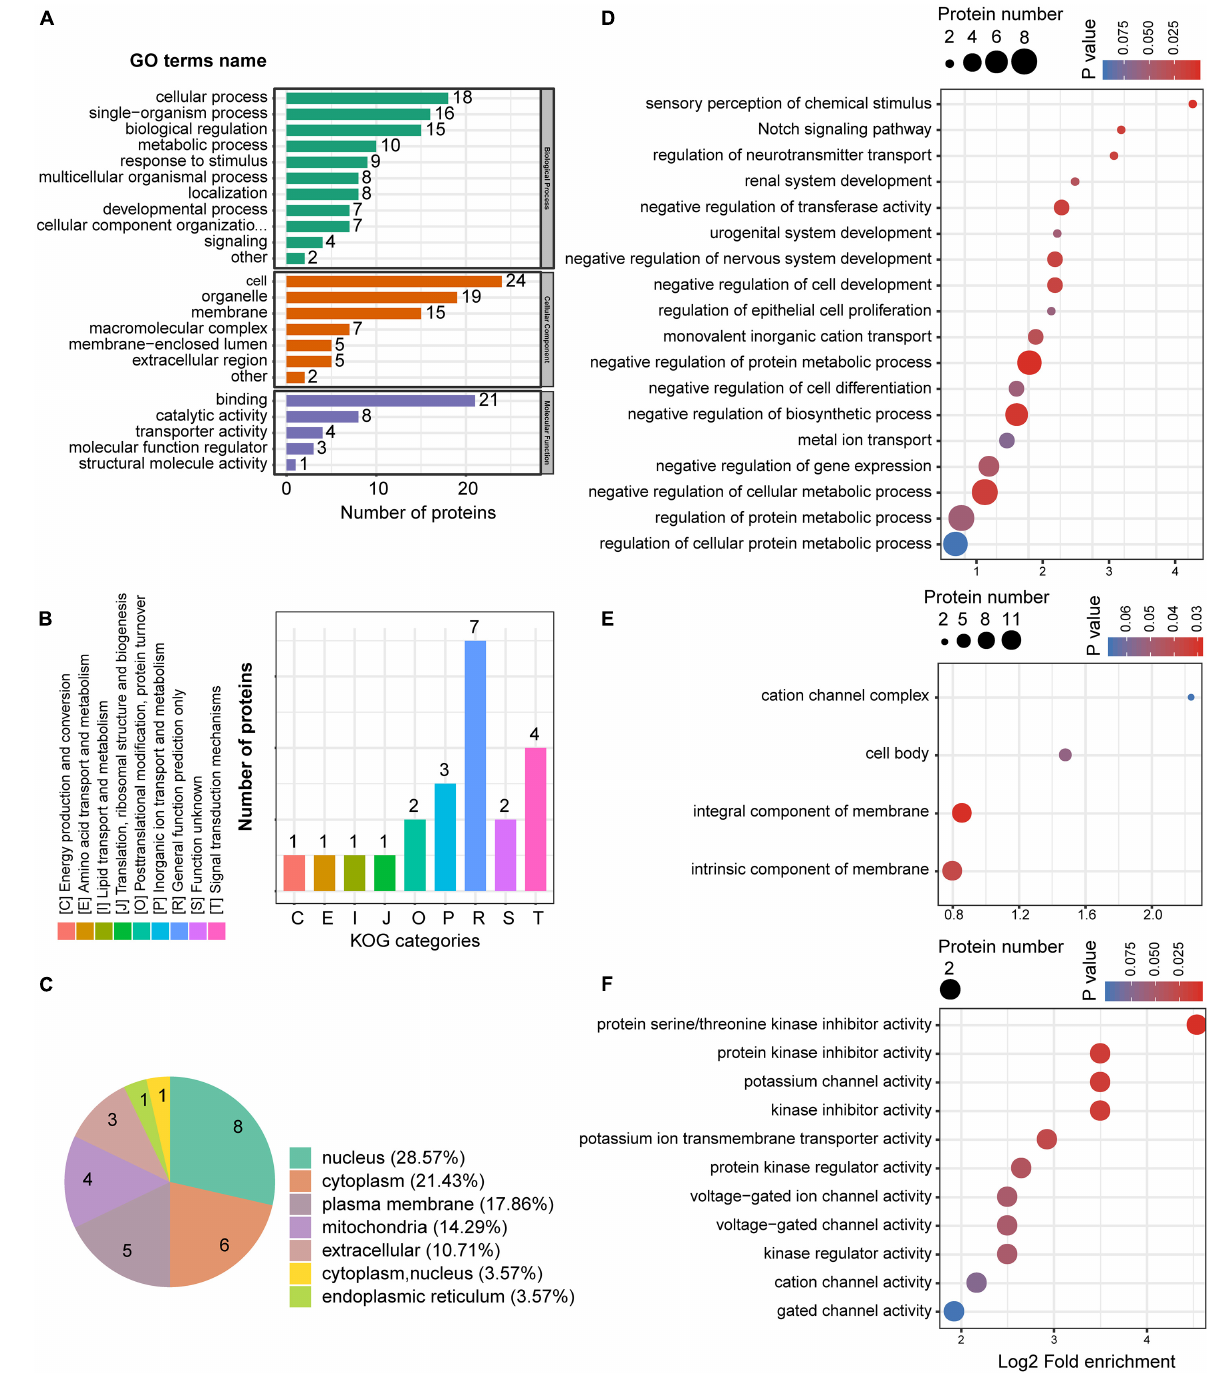
GFAP expression, we first performed GFAP staining in the